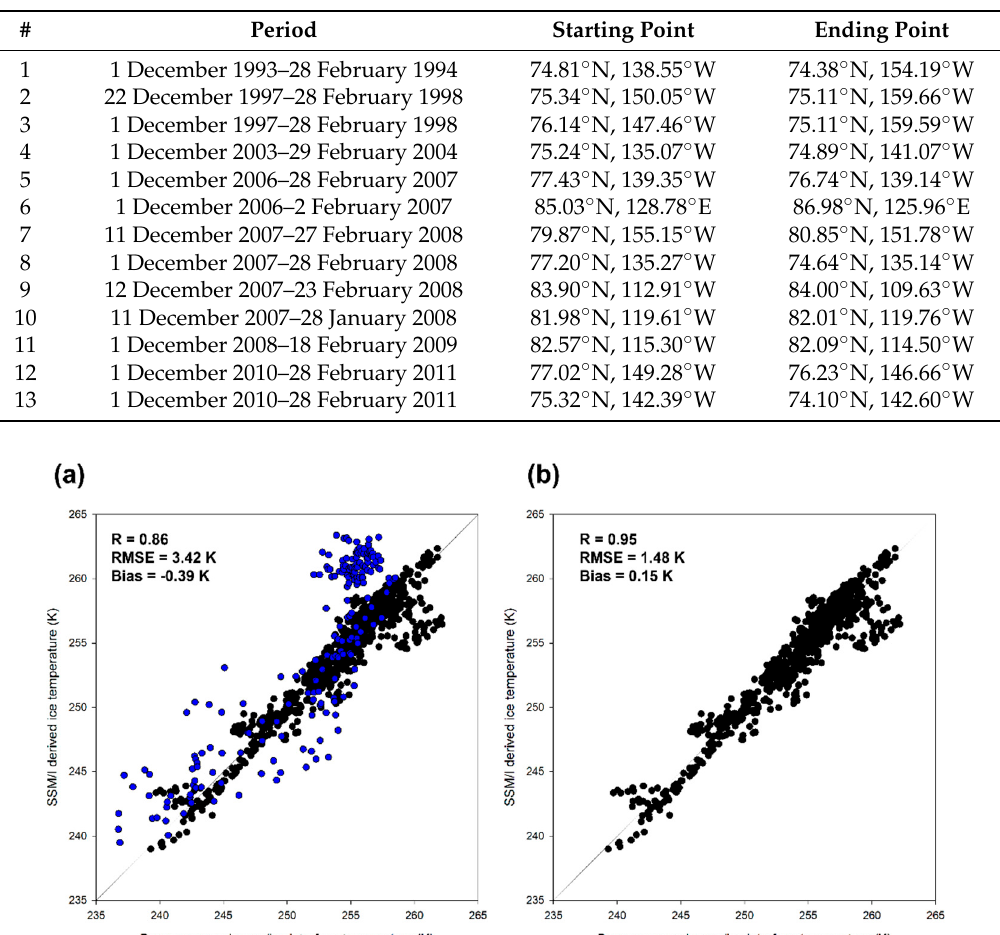
Figure 7. ( a ) Scatterplots between CRREL IMB buoy-measured snow/ice interface temperature (x-axis) and SSM/I-derived temperature (y-axis), from ( a ) all 13 buoys, and from ( b ) buoys after the quality check is applied.